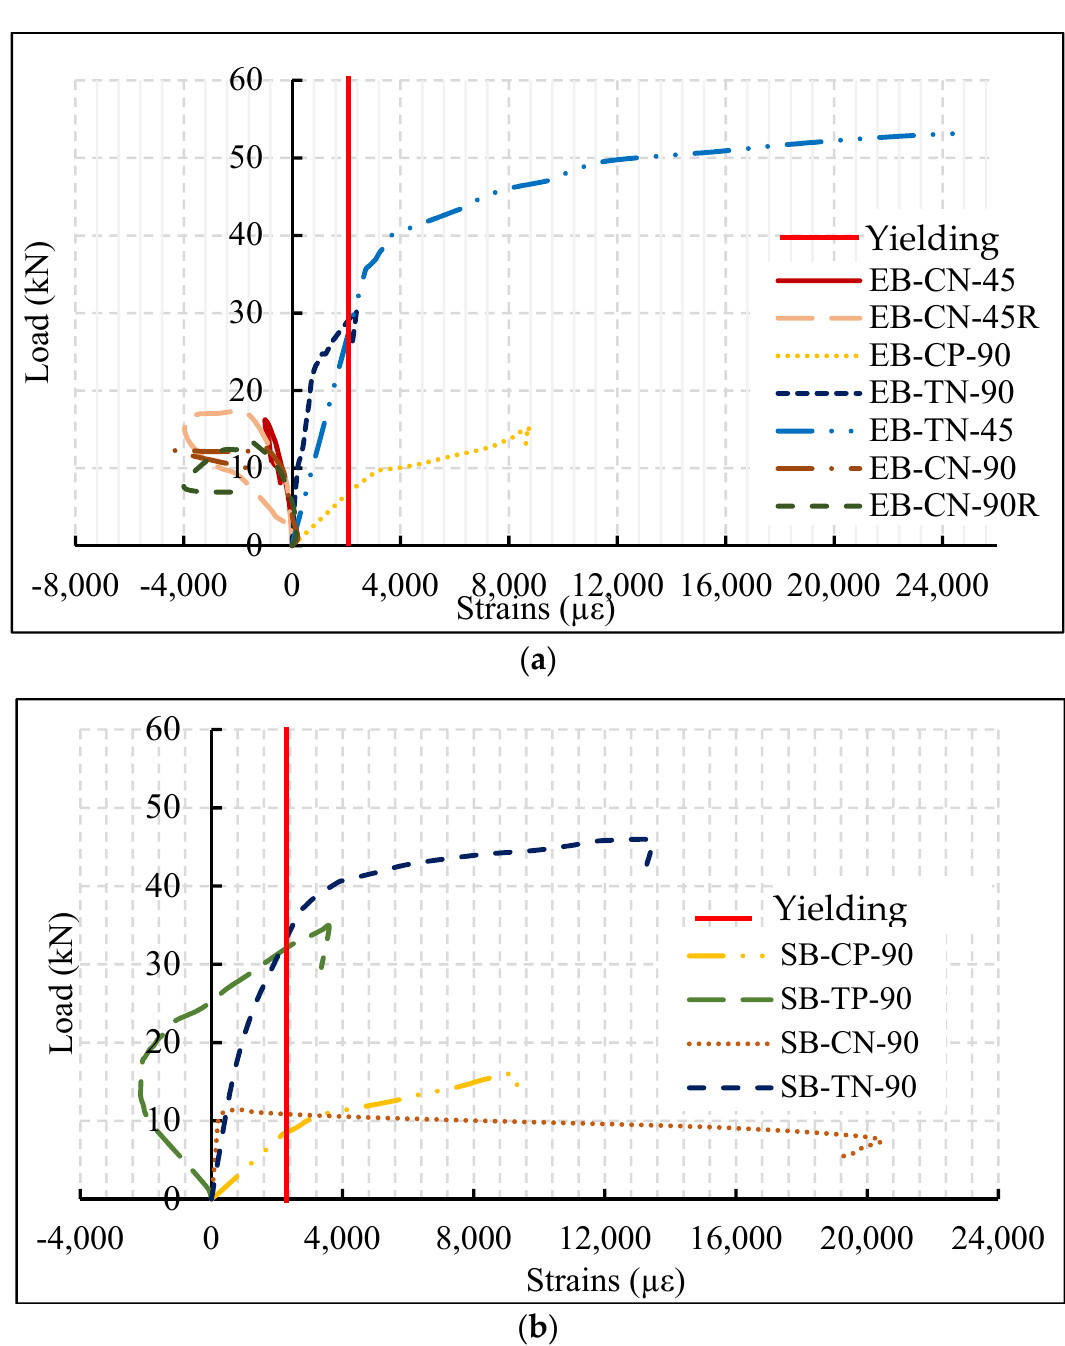
Figure 10. Load-strain relationship for the connection bar at the centerline before the bend: ( a ) Series I—end-bearing specimens, and ( b ) Series II—side-bearing specimens.